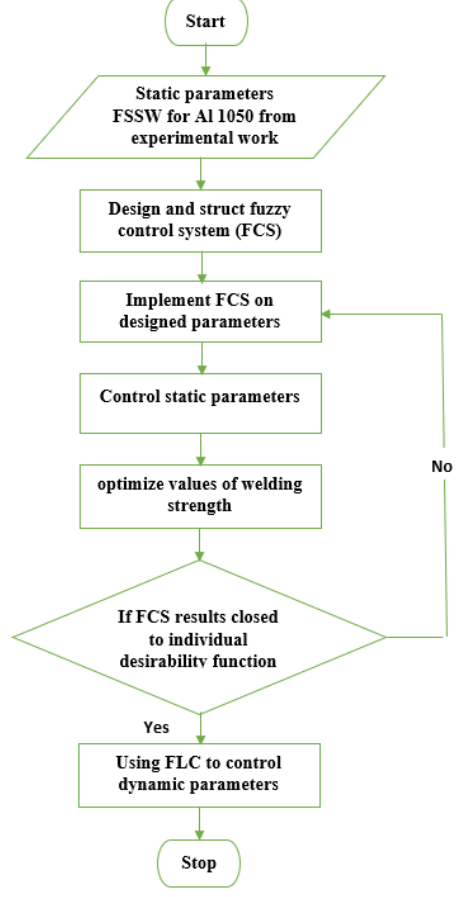
Figure 5. Flow chart of FLCS to optimize FSSW strength.